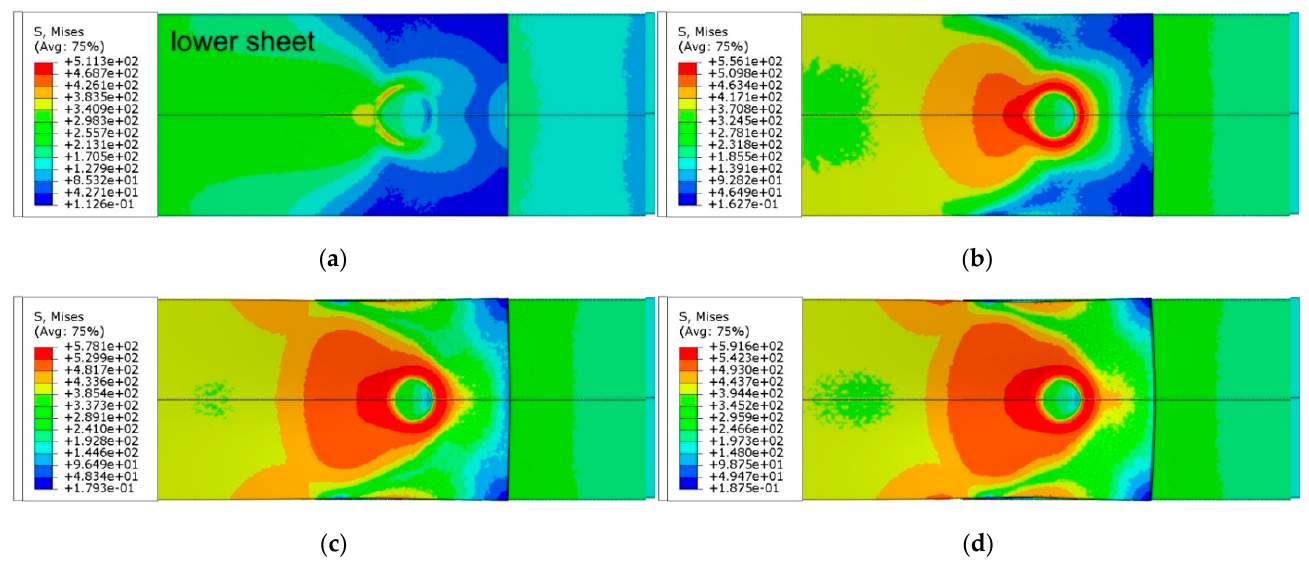
Figure 23. Distribution of equivalent von Mises stress (in MPa) in the RFSSW joint under tensile shear loading at different displacements (view on the bottom of weld): ( a ) 0.45 mm, ( b ) 0.9 mm, ( c ) 1.35 mm and ( d ) 1.8 mm.